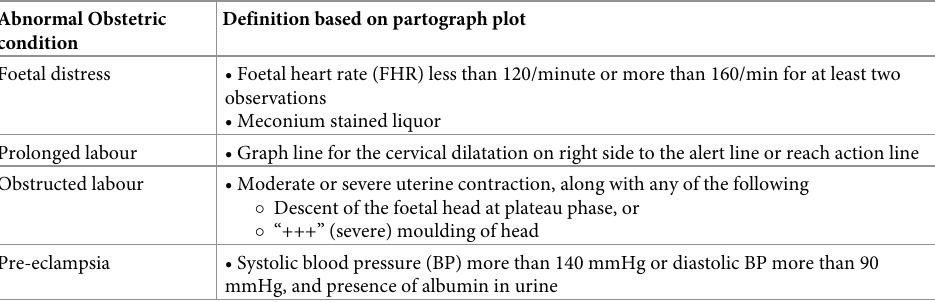
Table 3. Definition of abnormal obstetric conditions using partograph